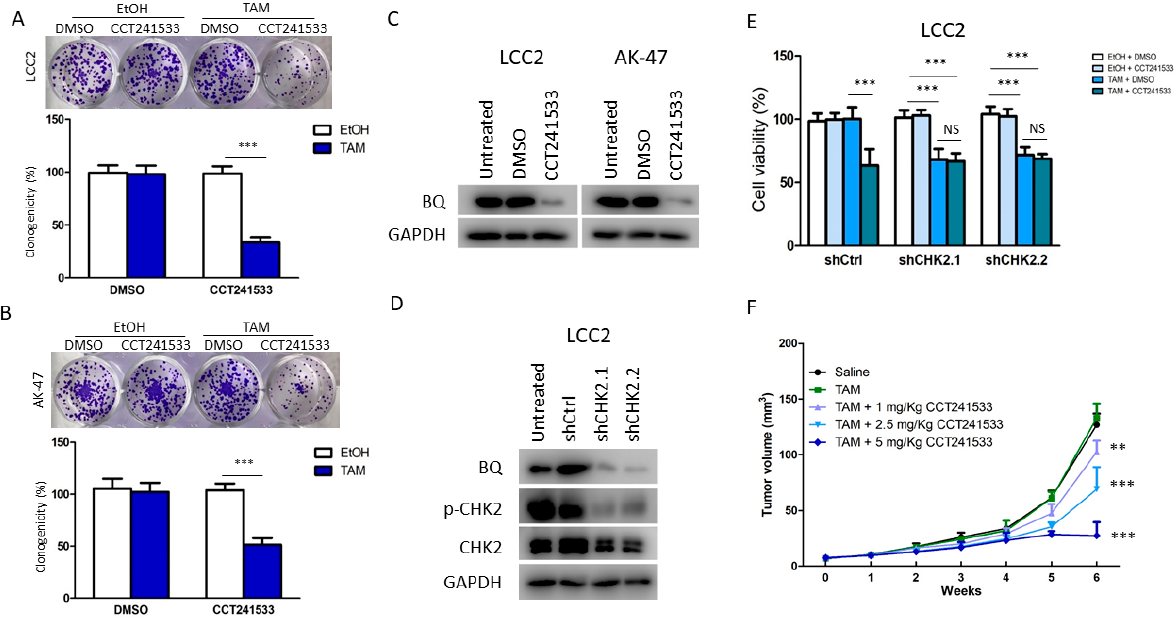
Figure 5. Targeting CHK2 by CCT241533 could reverse TAM resistance. The long-term effect of KU- 55933 on TAM response in ( A ) LCC2 and ( B ) AK-47. The cells were treated with 10 nM of CCT241533 and 4 µM of TAM for 14 days. A clonogenic assay was employed to determine cell viability. Student’s t -test was employed to compare the statistical significance between DMSO and TAM groups. ( C ) The effect of CCT241533 on BQ expression. LCC2 and AK-47 were treated with 10 nM of CCT241533 for 72 h. Western blot was employed to determine BQ expression. GAPDH was used as the loading control. ( D ) The knockdown efficiency of shRNA against CHK2. LCC2 cells were stably transfected to establish cell lines with stable CHK2 knockdown. Two independent stable clones were selected. Western blot was employed to detect the expression of BQ, p-CHK2 (Thr68) and CHK2. GAPDH was used as the loading control. ( E ) Knockdown of CHK2 could abolish the effect of CCT241533 on reversing TAM resistance. LCC2 and AK-47 were treated with 10 nM of CCT241533 and 4 µM of TAM for 96 h. Cell viability was determined by MTT assay. One-way ANOVA with Bonferroni’s post-test was employed to compare the statistical significance with indicated groups. ( F ) CCT241533 could reduce TAM resistance in female nude mice. LCC2 cells were used for establishing xenografts. The mice were treated with saline, TAM (0.5 mg/Kg) and CCT241533 (1 mg/Kg, 2.5 mg/Kg and 5 mg/Kg) via subcutaneous injection. The mice were treated twice per week for six weeks. The tumour growth curve was plotted. Two-way ANOVA with Turkey post-test was employed to compare the statistical significance with the saline group: ** p < 0.01 and *** p < 0.001.